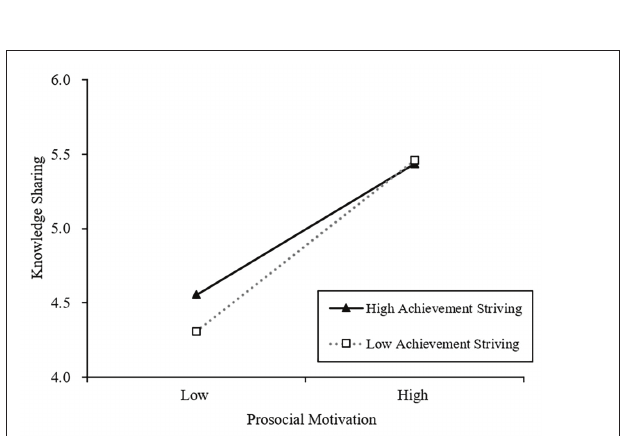
FIGURE 3 | The moderating effect of achievement striving in the relation between prosocial motivation and knowledge